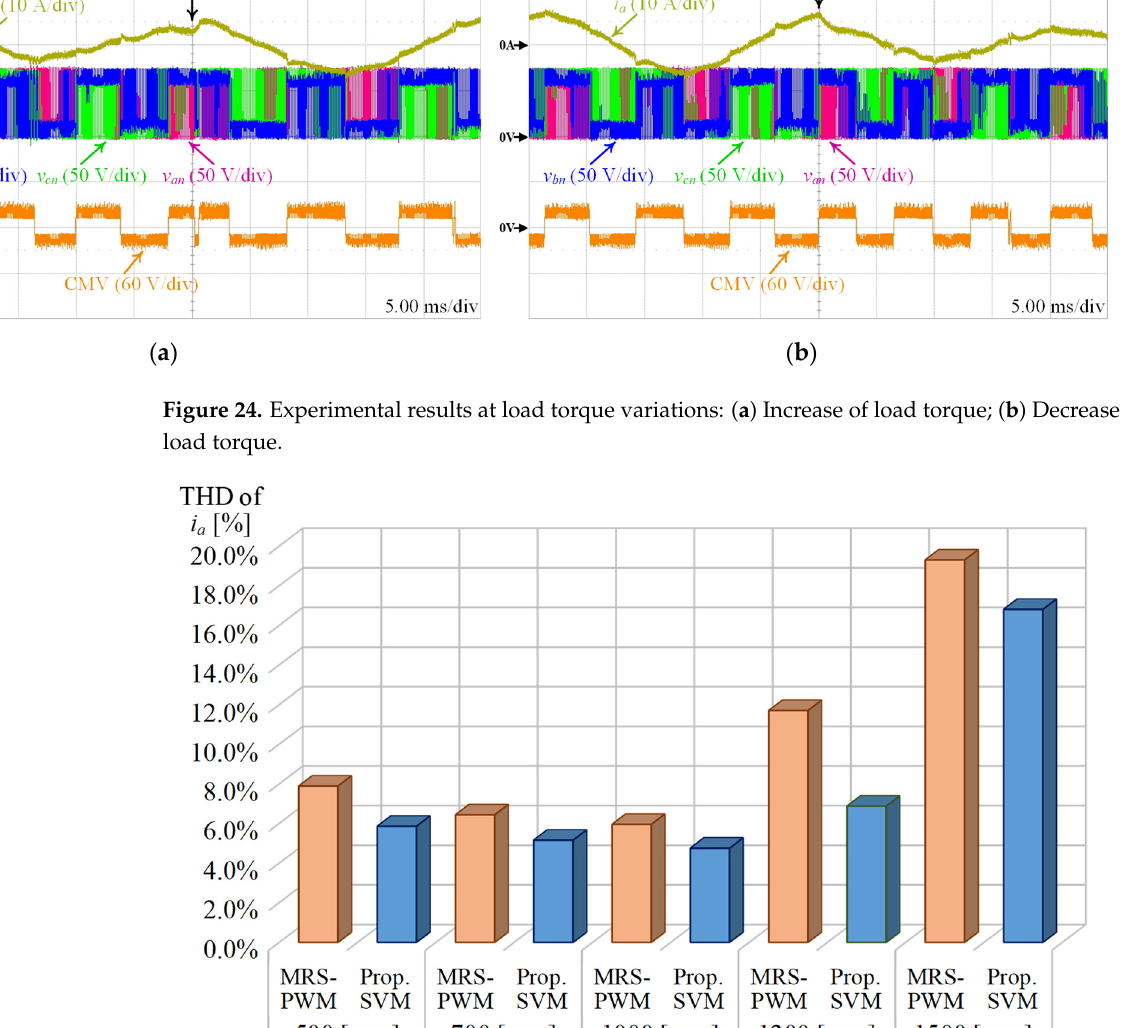
Figure 25. Comparison of current THD between MRSPWM and proposed method.